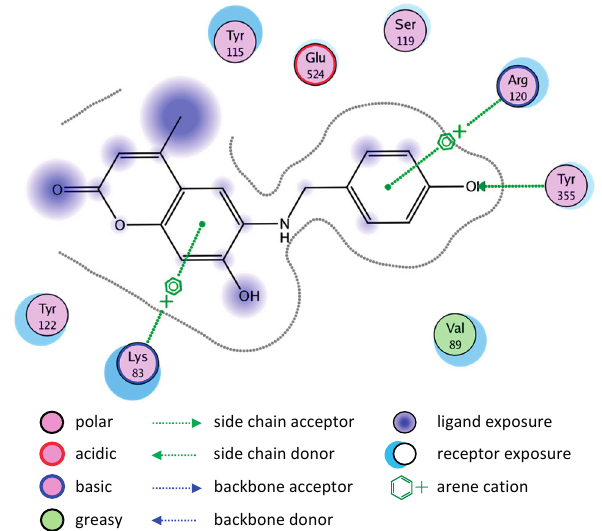
Figure 3. 2D representation of docking of compound 1 into the COX-2 active